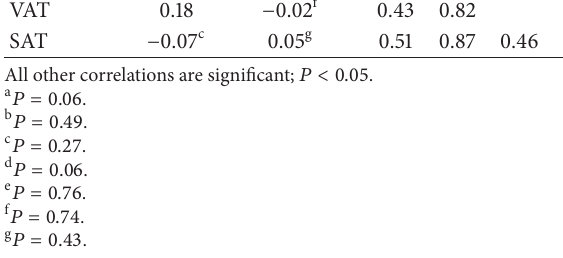
Table 5: Multiple linear regression including TAT, VAT, and SAT as independent predictors of BMD in group aged ≥ 55, adjusting